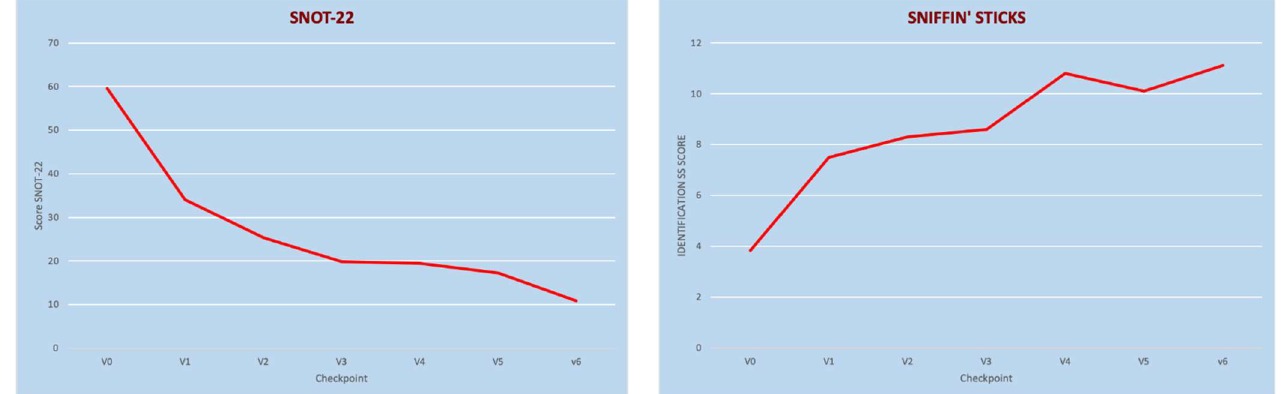
Figure 2. SNOT-22 ( left panel ) and Sniffin’Sticks-16 Identification Test ( right panel ) over time. V0: visit at baseline; V1: 15 days of treatment; V2: 1 month; V3: 3 months of treatment; V4: 6 months of treatment; V6: 12 months of treatment).